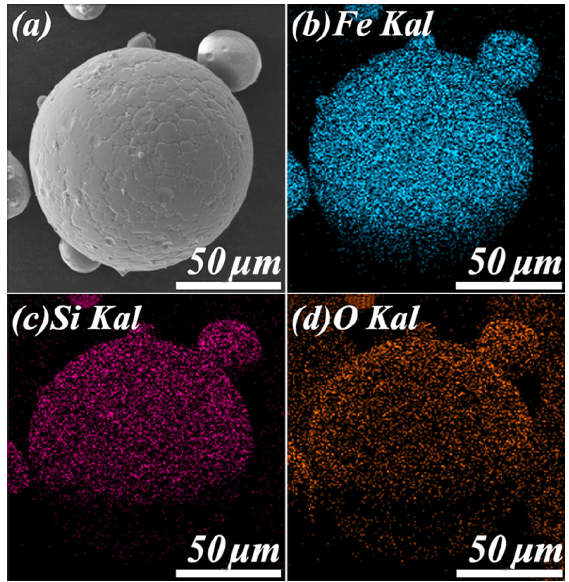
Figure 1. ( a ) SEM morphology of Fe–Si/SiO 2 composite particles deposited at an Ar dilution gas flow rate of 250 mL/min and elemental distribution images of Fe ( b ), Si ( c ), and O ( d ).